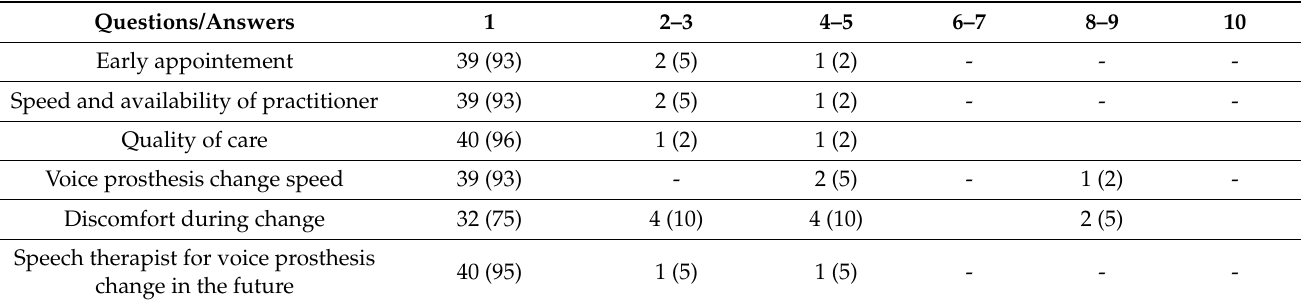
Table 2. Responses to